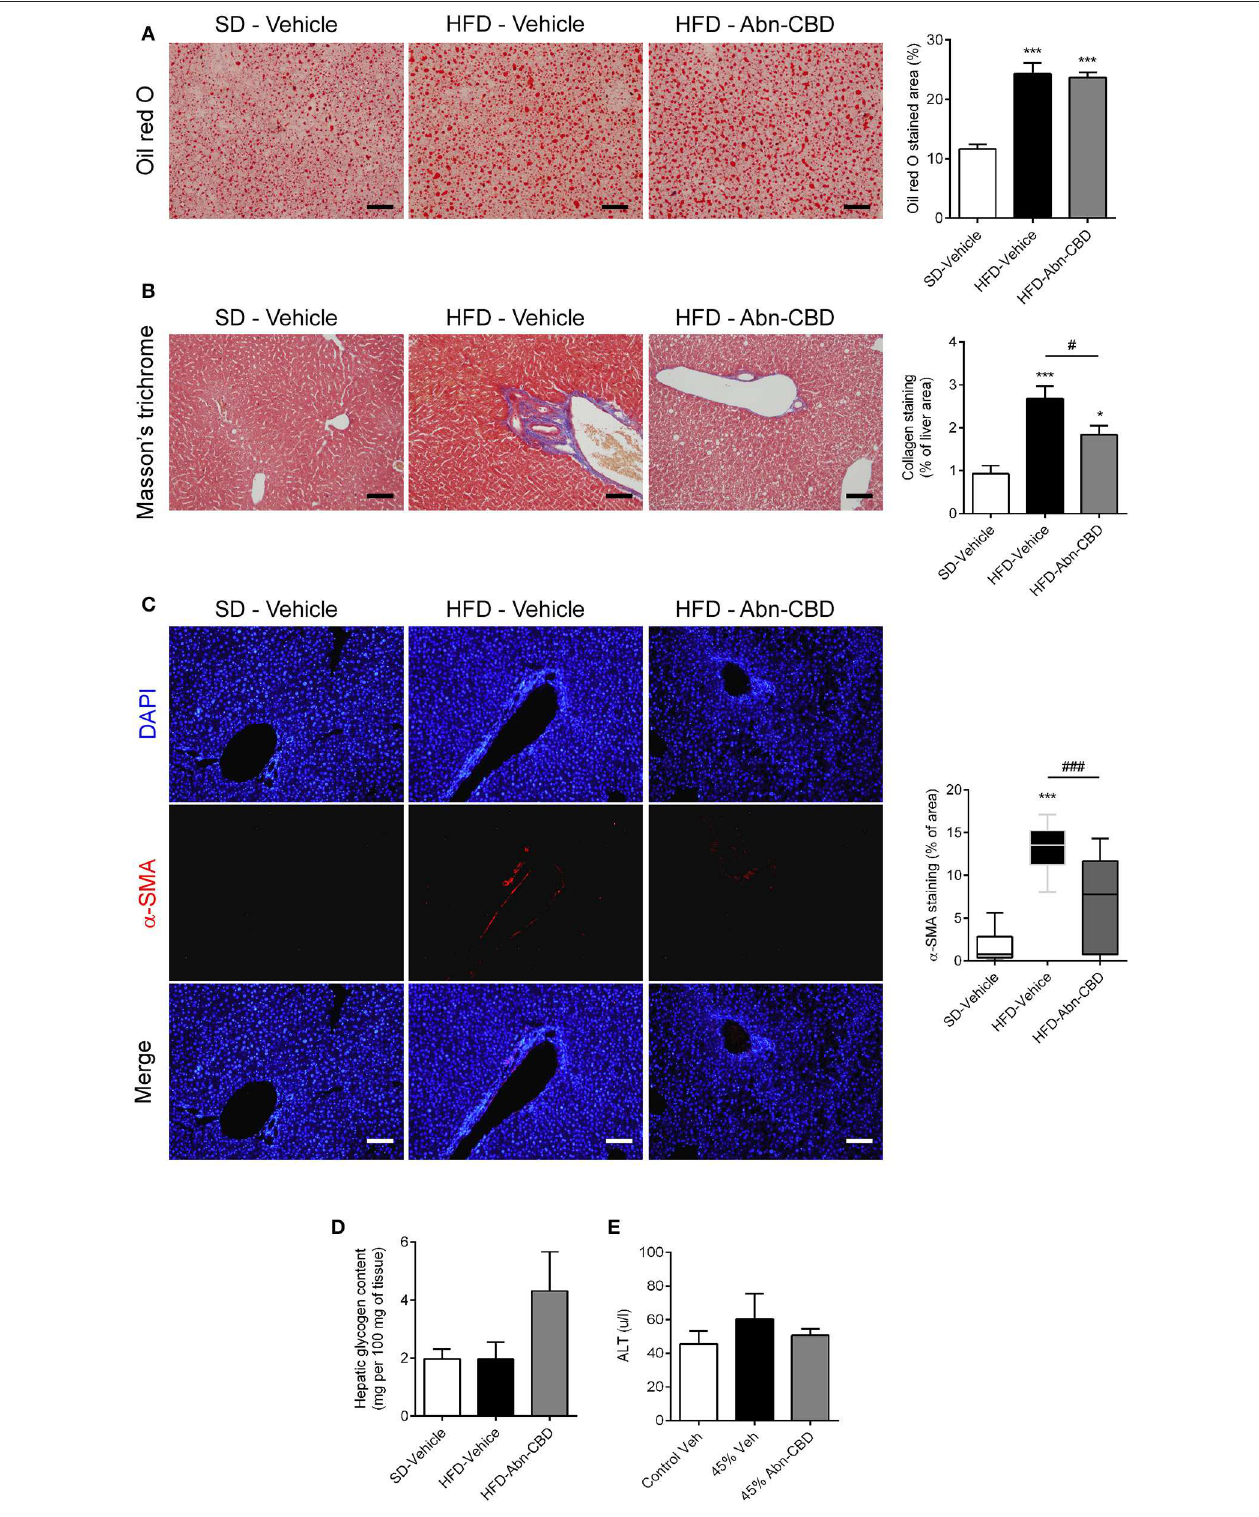
FIGURE 6 | Effect of Abn-CBD on liver structure and function. Representative photomicrographs and quantification of livers stained for lipid droplets (A) and collagen fibers (B) , scale bar is 100 µ m. Representative photomicrographs of immunofluorescence in liver for α -SMA (red), counterstained with DAPI (in blue) (C) . Biochemical determination of hepatic glycogen content (D) and circulating levels of alanine aminotransferase (E) . n = 7–8 SD-Vehicle, n = 5–8 HFD-Vehicle and n = 6–8 HFD-Abn-CBD. * p ≤ 0.05 and *** p ≤ 0.001 compared to SD-Vehicle; # p ≤ 0.05 and ### p ≤ 0.001 compared to HFD-Vehicle.